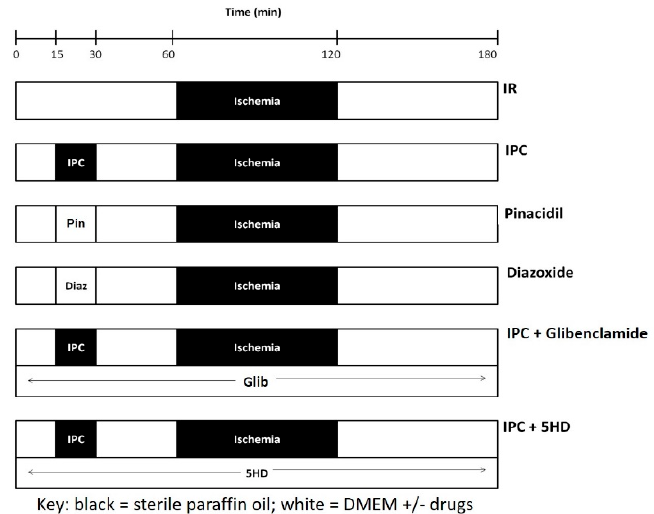
Figure 1. Protocols utilized to determine the effect of ischemia-reperfusion (IR) injury and of ischemic preconditioning (IPC) on rat cardiac fibroblast to myofibroblast differentiation. IR injury was produced by subjecting freshly isolated cardiac cells to ischemia at 37 °C. Reperfusion lasted 60 min. IPC was induced by preceding the IR with 15 min ischemia and 30 min reperfusion. IPC was mimicked by the application of K ATP channel openers pinacidil (Pin, 3rd row) or diazoxide (Diaz, 4th row). The effect of blocking K ATP current on IPC was tested by including glibenclamide (Glib, 5th row) or 5-hydroxydecanoate (5HD, 6th row). Key: black boxes represent periods where ischemia was mimicked by layering sterile paraffin oil onto the cells, whereas, white boxes represent periods where cells were covered with DMEM, with or without drugs, as specified.